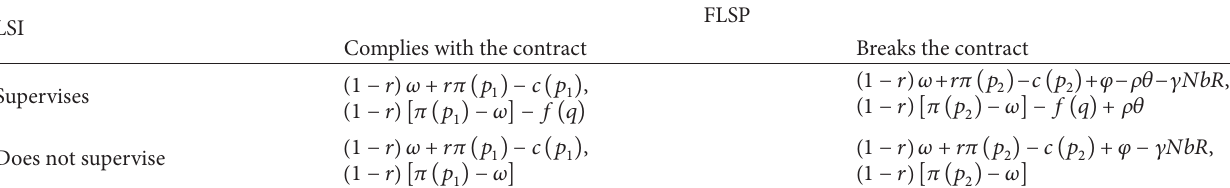
Table 2: Expected revenue matrix of the LSI and FLSP 𝑖 considering FLSP’s competition.